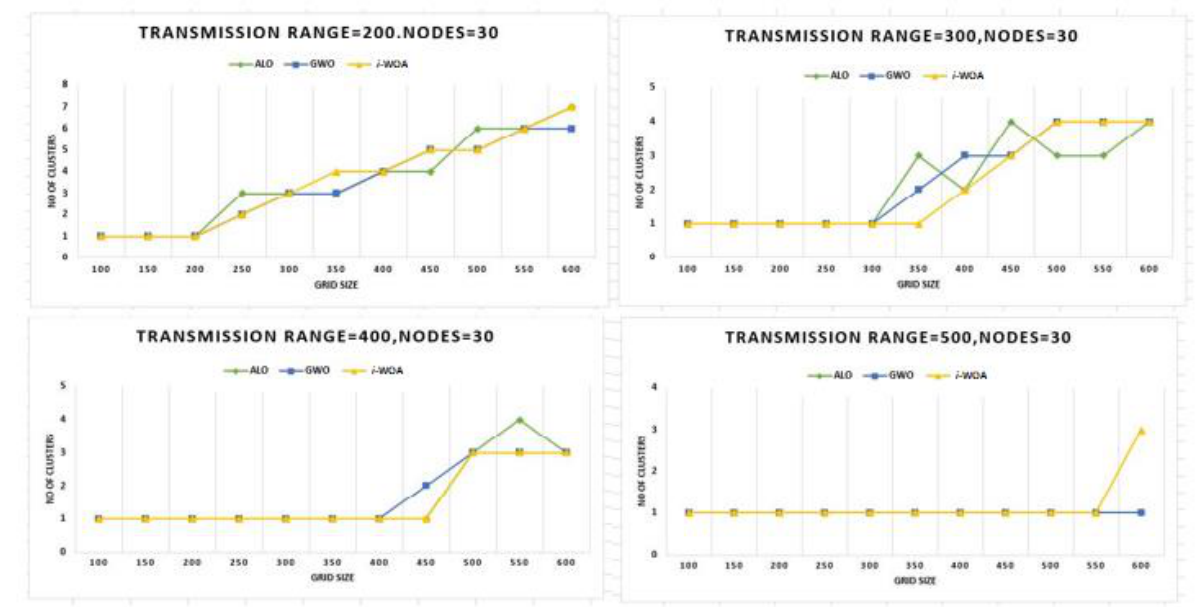
Figure 5. Comparison of 30 Nodes on a Grid with Different Numbers of Clusters.